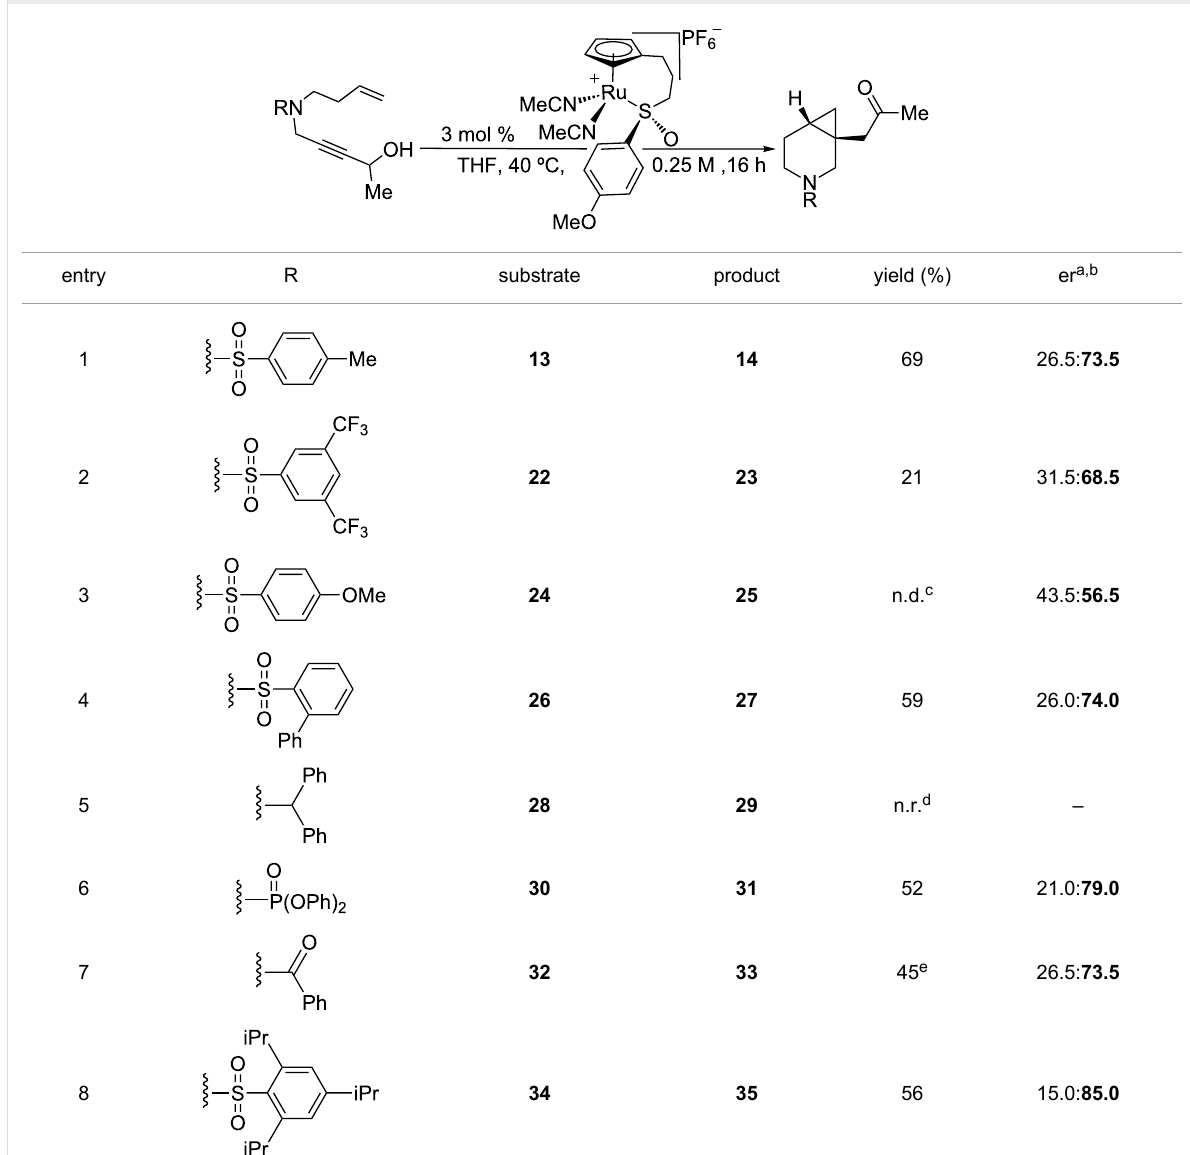
Table 5: Effect of the nitrogen protecting group on reactivity and enantioselectivity as described in